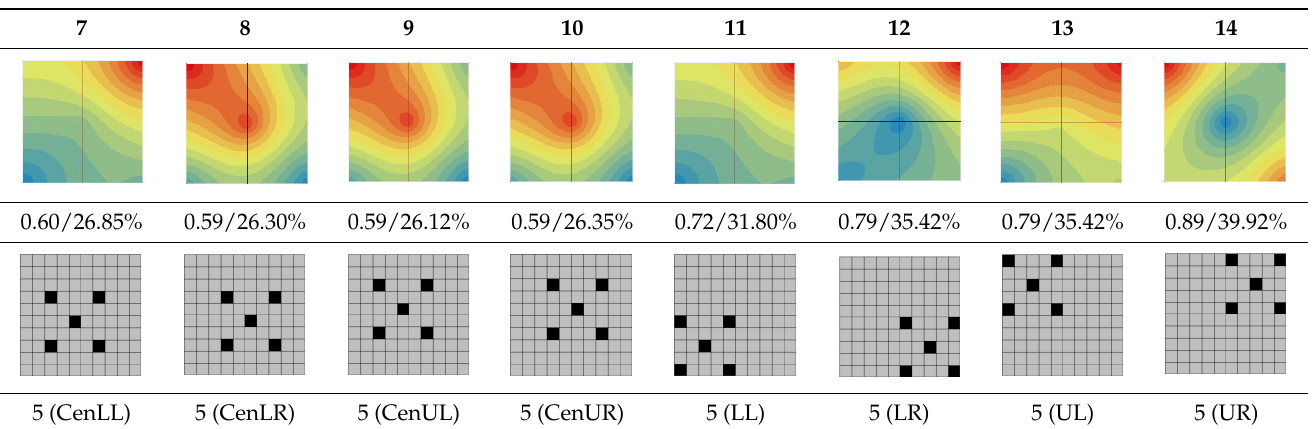
RMSE (kg/m 2 ) ¶ The black and gray boxes show the training and testing samples for cokriging model derivation and accuracy evaluation, ¶ The black and gray boxes show the training and testing samples for cokriging model derivation and accuracy evaluation, ¶ The black and gray boxes show the training and testing samples for cokriging model derivation and accuracy evaluation, ¶ The black and gray boxes show the training and testing samples for cokriging model derivation and accuracy evaluation, ¶ The black and gray boxes show the training and testing samples for cokriging model derivation and accuracy evaluation, ¶ The black and gray boxes show the training and testing samples for cokriging model derivation and accuracy evaluation, ¶ The black and gray boxes show the training and testing samples for cokriging model derivation and accuracy evaluation, ¶ The black and gray boxes show the training and testing samples for cokriging model derivation and accuracy evaluation, ¶ The black and gray boxes show the training and testing samples for cokriging model derivation and accuracy evaluation, ¶ The black and gray boxes show the training and testing samples for cokriging model derivation and accuracy evaluation, ¶ The black and gray boxes show the training and testing samples for cokriging model derivation and accuracy evaluation, ¶ The black and gray boxes show the training and testing samples for cokriging model derivation and accuracy evaluation, ¶ The black and gray boxes show the training and testing samples for cokriging model derivation and accuracy evaluation, ¶ The black and gray boxes show the training and testing samples for cokriging model derivation and accuracy evaluation, ¶ The black and gray boxes show the training and testing samples for cokriging model derivation and accuracy evaluation, ¶ The black and gray boxes show the training and testing samples for cokriging model derivation and accuracy evaluation, respectively. The size value comes after the symbol “@” presenting the area of a microplot. respectively. The size value comes after the symbol “@” presenting the area of a microplot. respectively. The size value comes after the symbol “@” presenting the area of a microplot. respectively. The size value comes after the symbol “@” presenting the area of a microplot. respectively. The size value comes after the symbol “@” presenting the area of a microplot. respectively. The size value comes after the symbol “@” presenting the area of a microplot. respectively. The size value comes after the symbol “@” presenting the area of a microplot. respectively. The size value comes after the symbol “@” presenting the area of a microplot. respectively. The size value comes after the symbol “@” presenting the area of a microplot. respectively. The size value comes after the symbol “@” presenting the area of a microplot. respectively. The size value comes after the symbol “@” presenting the area of a microplot. respectively. The size value comes after the symbol “@” presenting the area of a microplot. respectively. The size value comes after the symbol “@” presenting the area of a microplot. respectively. The size value comes after the symbol “@” presenting the area of a microplot. respectively. The size value comes after the symbol “@” presenting the area of a microplot. respectively. The size value comes after the symbol “@” presenting the area of a microplot. Table 7. A comparison of appropriateness of extended prediction based on the predefined cokriging surface fuel load map Table 7. A comparison of appropriateness of extended prediction based on the predefined cokriging surface fuel load map Table 7. A comparison of appropriateness of extended prediction based on the predefined cokriging surface fuel load map Table 7. A comparison of appropriateness of extended prediction based on the predefined cokriging surface fuel load map Table 7. A comparison of appropriateness of extended prediction based on the predefined cokriging surface fuel load map Table 7. A comparison of appropriateness of extended prediction based on the predefined cokriging surface fuel load map Table 7. A comparison of appropriateness of extended prediction based on the predefined cokriging surface fuel load map Table 7. A comparison of appropriateness of extended prediction based on the predefined cokriging surface fuel load map Table 7. A comparison of appropriateness of extended prediction based on the predefined cokriging surface fuel load map Table 7. A comparison of appropriateness of extended prediction based on the predefined cokriging surface fuel load map Table 7. A comparison of appropriateness of extended prediction based on the predefined cokriging surface fuel load map Table 7. A comparison of appropriateness of extended prediction based on the predefined cokriging surface fuel load map Table 7. A comparison of appropriateness of extended prediction based on the predefined cokriging surface fuel load map Table 7. A comparison of appropriateness of extended prediction based on the predefined cokriging surface fuel load map Table 7. A comparison of appropriateness of extended prediction based on the predefined cokriging surface fuel load map Table 7. A comparison of appropriateness of extended prediction based on the predefined cokriging surface fuel load map ¶ . ¶ . ¶ . ¶ . ¶ . ¶ . ¶ . ¶ . ¶ . ¶ . ¶ . ¶ . ¶ . ¶ . ¶ . ¶ . Table 7. A comparison of appropriateness of extended prediction based on the predefined cokriging surface fuel load map ¶ .